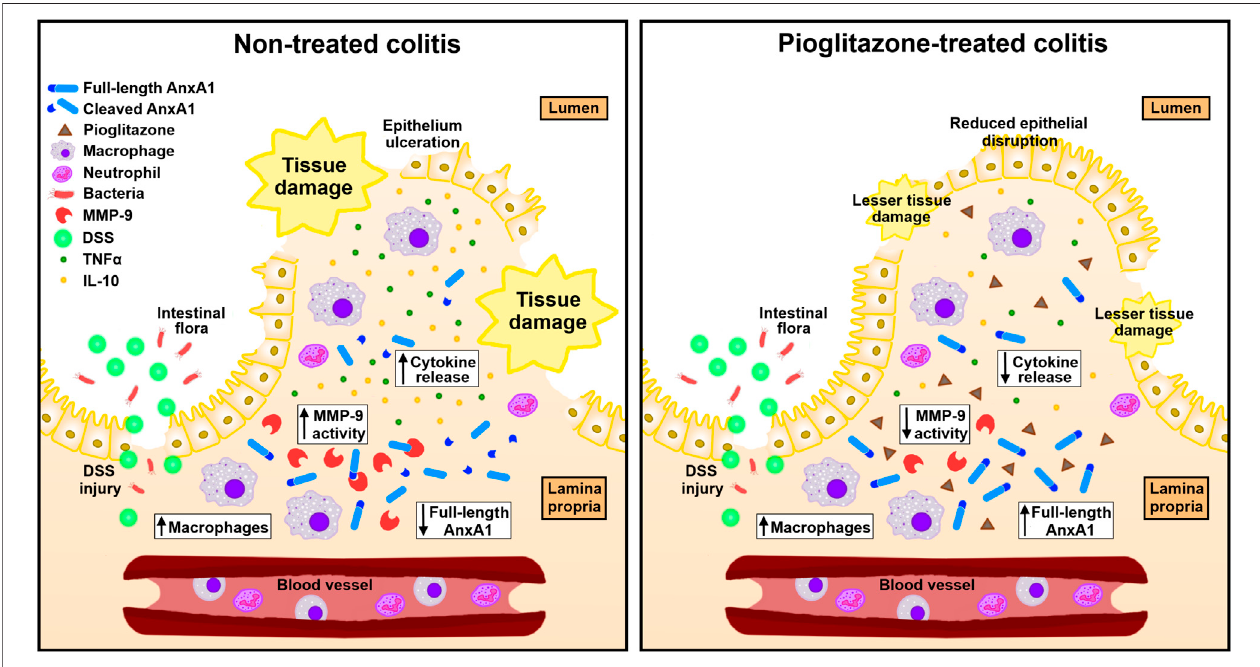
FIGURE 9 | Schematics of connections between pioglitazone effects and AnxA1 on experimental colitis. In experimental colitis induced by DSS, tissue injury exposesintestinallaminapropriatogutmicroorganismstriggeringin fl ammationandincreasingthenumberofAnxA1-releasingmacrophages.AnxA1releasedthiswayis cleaved into smaller, non-functional fragments by proteolytic enzymes such as MMP-9, which impairs its anti-in fl ammatory actions leading to greater secretion of cytokines such as TNF α and IL-10 and causing overall disruption of the intestinal tissue. Upon treatment with pioglitazone, MMP-9 expression decreases and causes AnxA1 released by macrophages to remain non-fragmented for longer, allowing it to promote its anti-in fl ammatory actions, decreasing cytokine secretion and reducing overall tissue disruption.